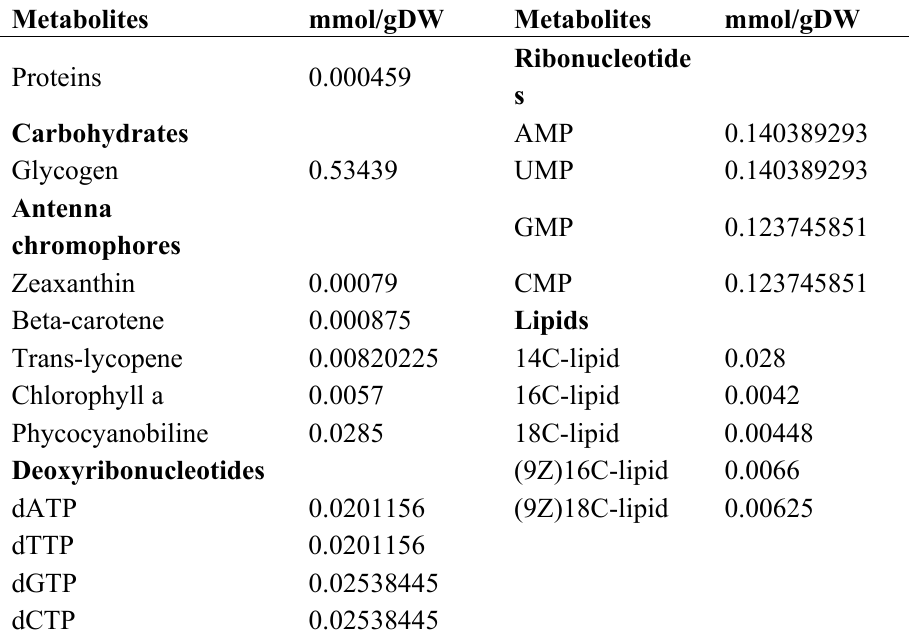
Table 4. Biomass composition of the S. elongatus PCC7942 metabolic